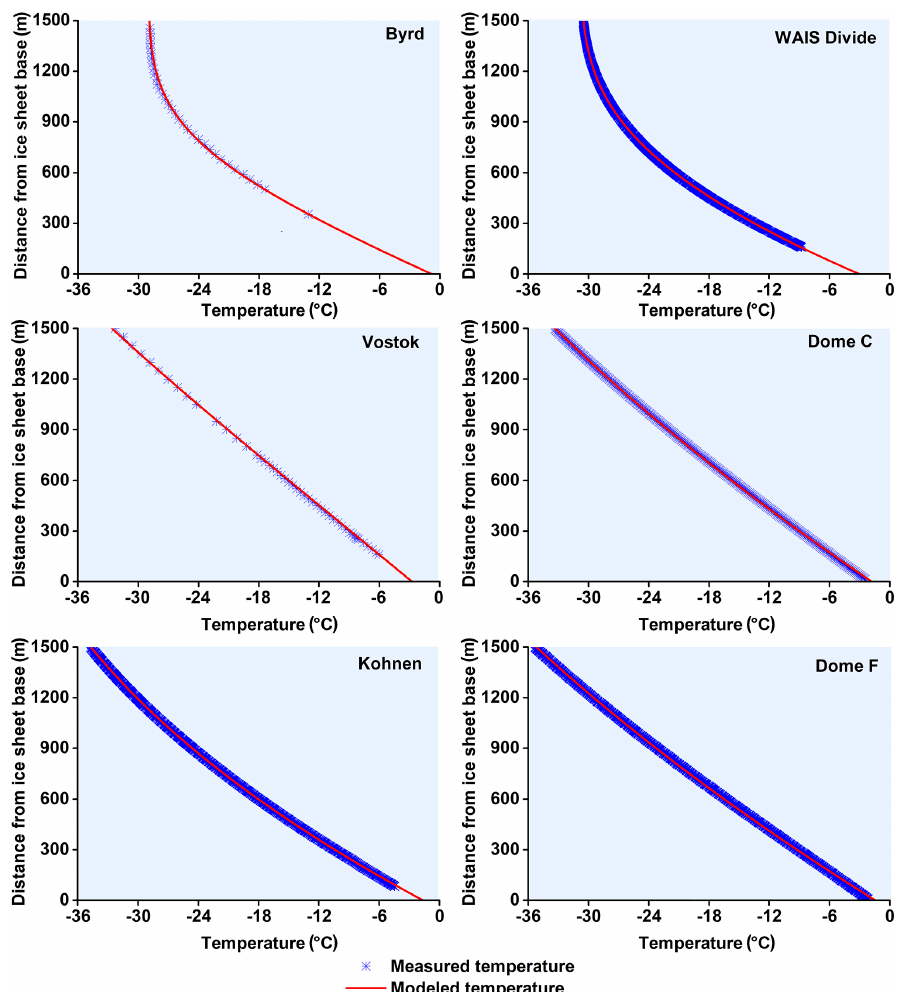
Figure 3. Temperatures measured in Antarctic deep ice boreholes compared with best-fit temperature profiles for the deepest